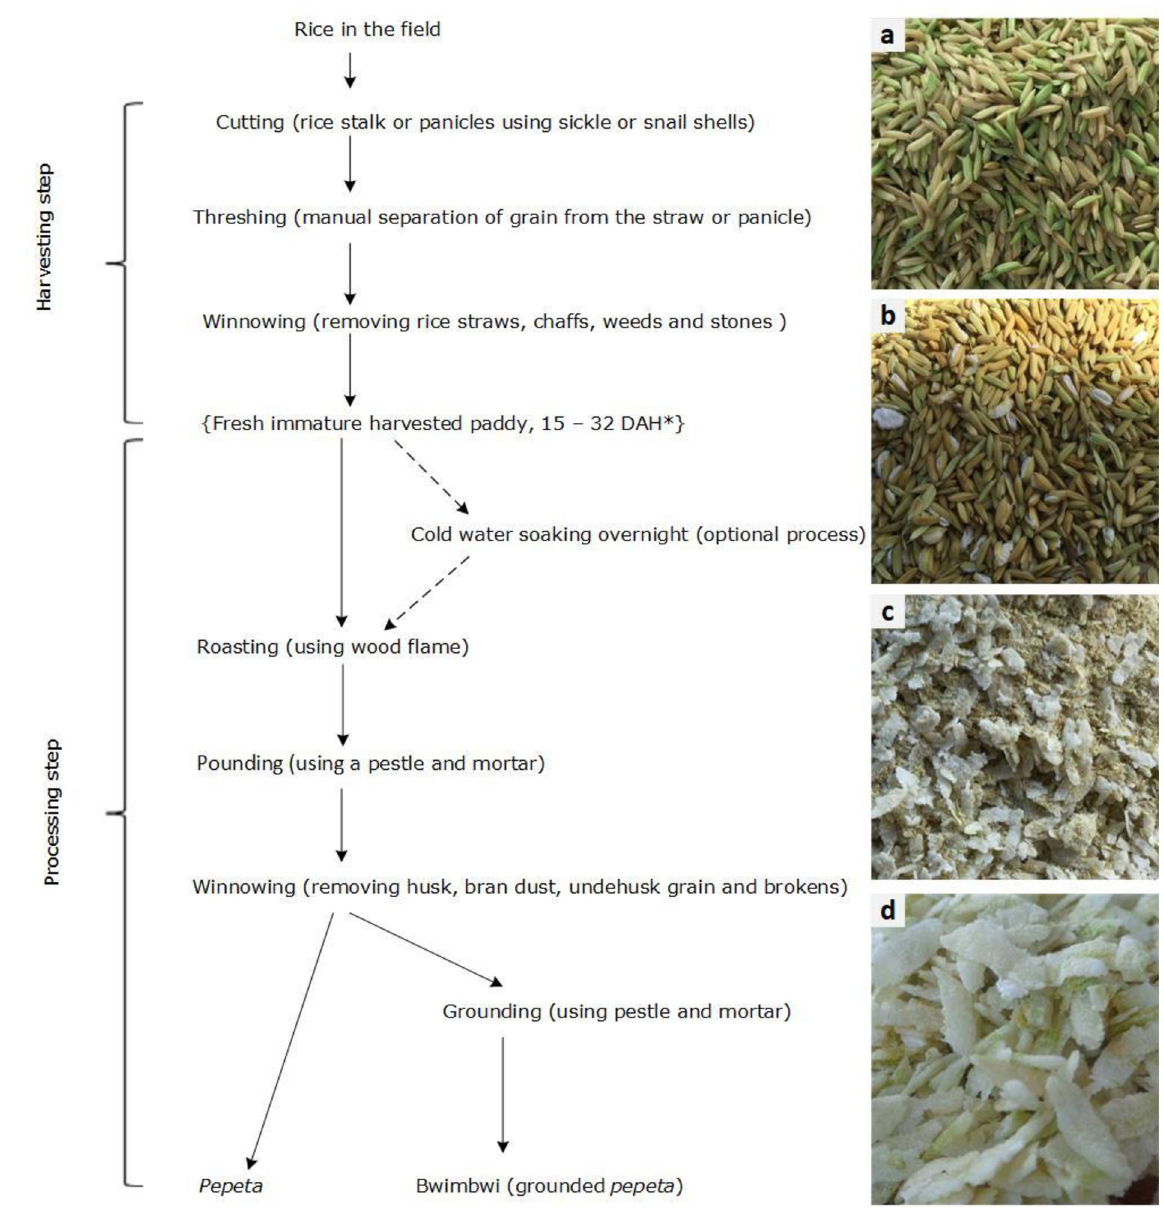
Fig 3. Pepeta processing flow diagram. DAH–days after 50% heading, a –fresh immature harvested paddy grains, b –roasted paddy grains, c – pounded paddy grains, and d– cleaned pepeta